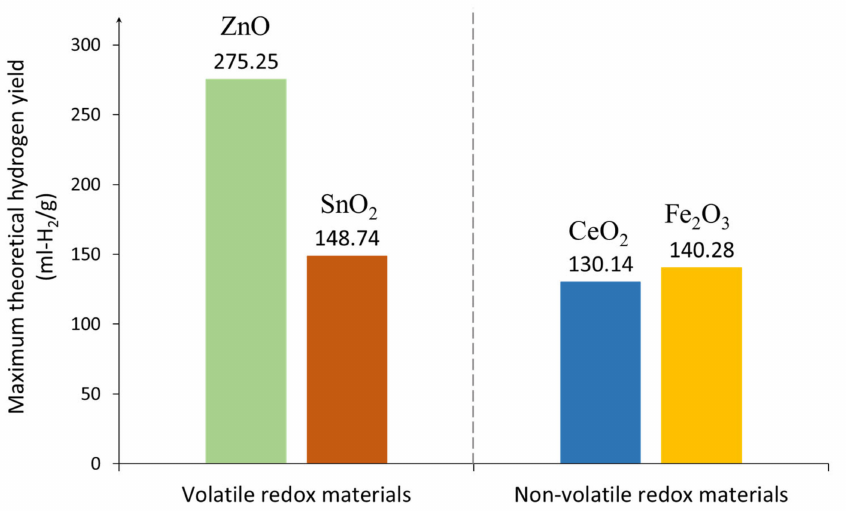
Figure 10. Comparison of the maximum theoretical hydrogen yields under standard conditions, calculated based on the redox limits for the volatile redox materials ZnO and SnO 2 and the non- volatile redox materials CeO 2 and Fe 2 O 3 . Redrawn from